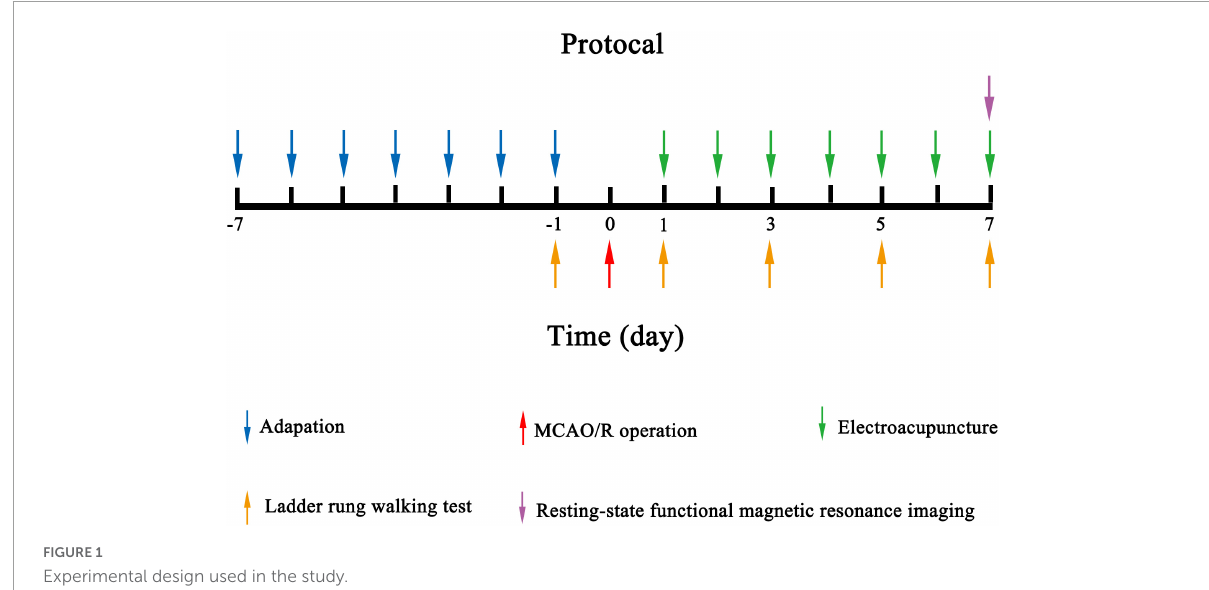
FIGURE1 Experimental design used in the